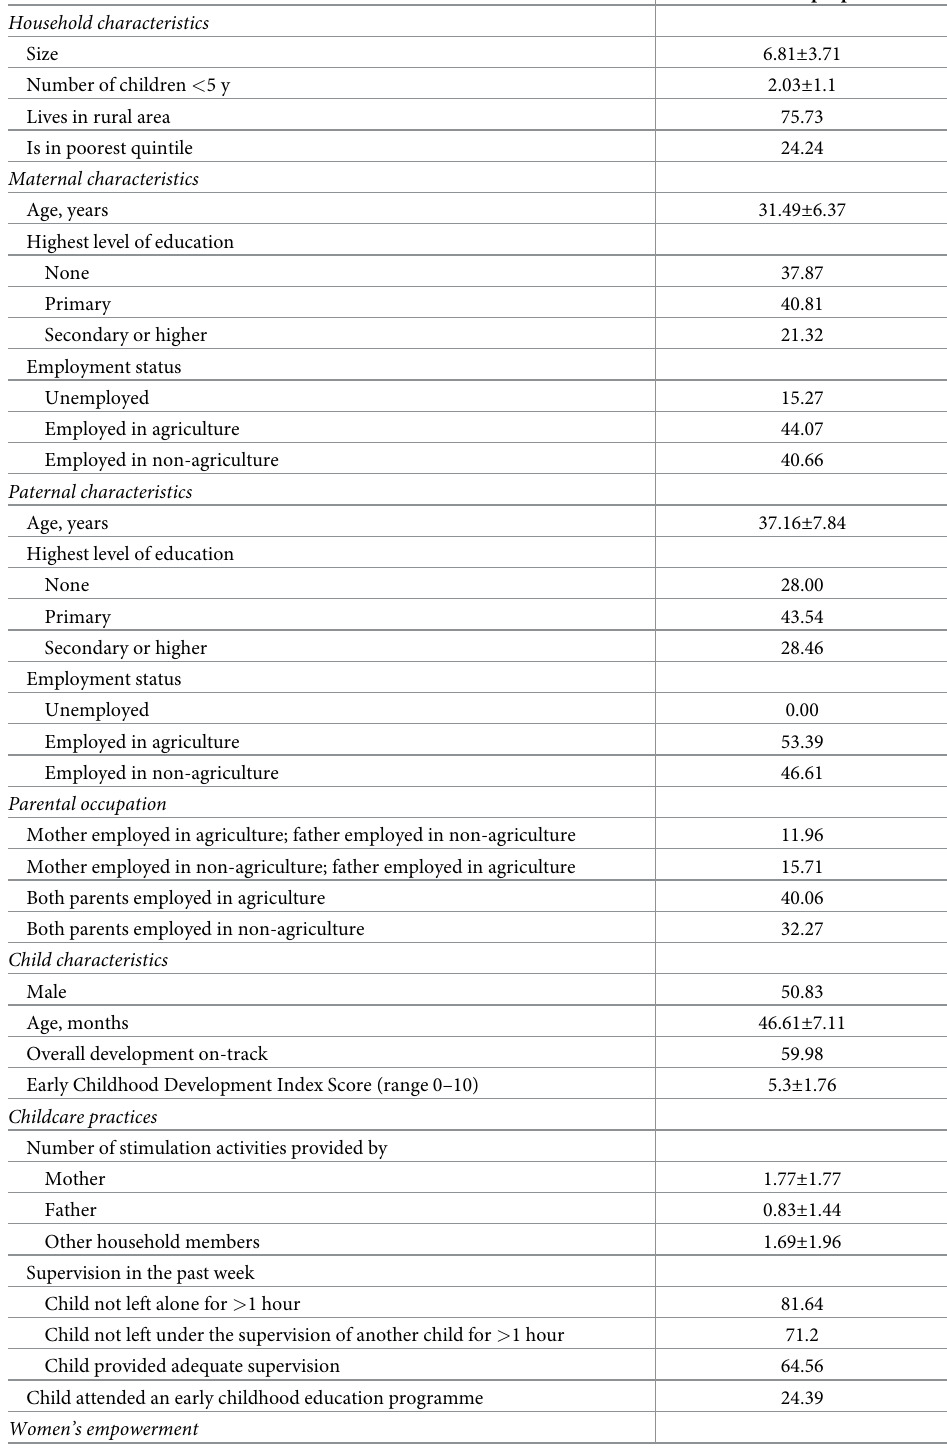
Table 1. Household, parental, and child characteristics of the 8,516 children aged 36–59 months in the analytic